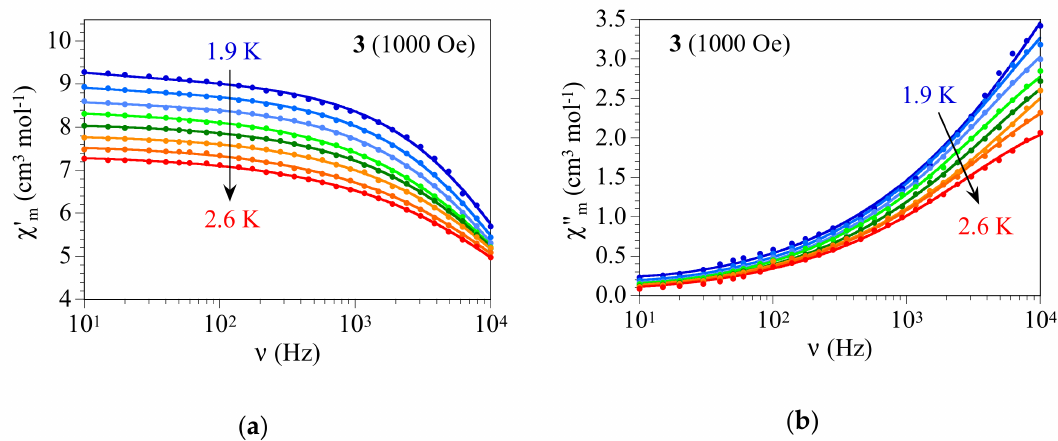
Figure 10. Frequency dependence of χ (cid:48) m ( a ) and χ (cid:48)(cid:48) m ( b ) for compound 3 with H dc = 1000 Oe in the Table 1. 9–2.6 K. Solid lines are the best fit to the Debye